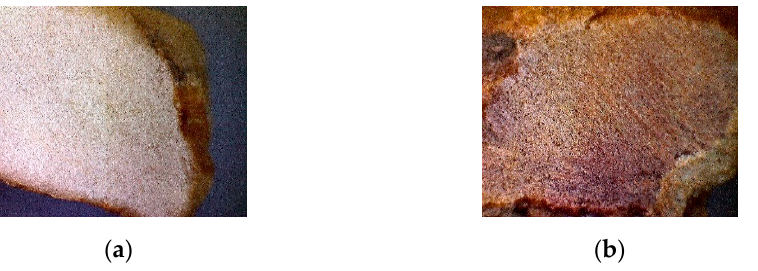
Figure 4. The 20× magnification images captured on polished surfaces of mosaic stone fragments: ( a ) M1(a) white marble, composition 100% CaCO 3 and ( b ) M1(b) dolomitic marble, reddish-brown, CaMg(CO 3 ) 2 with Fe 2 O 3 impurities).